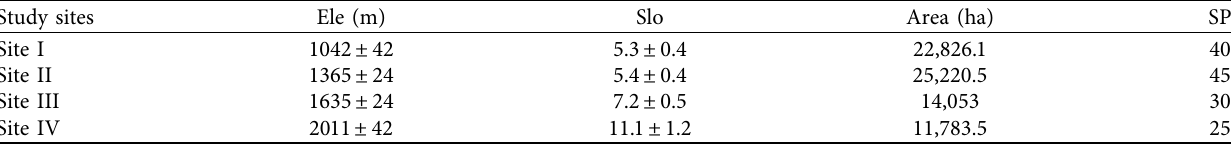
Table 1: Topographic and soil characteristics of the study sites.